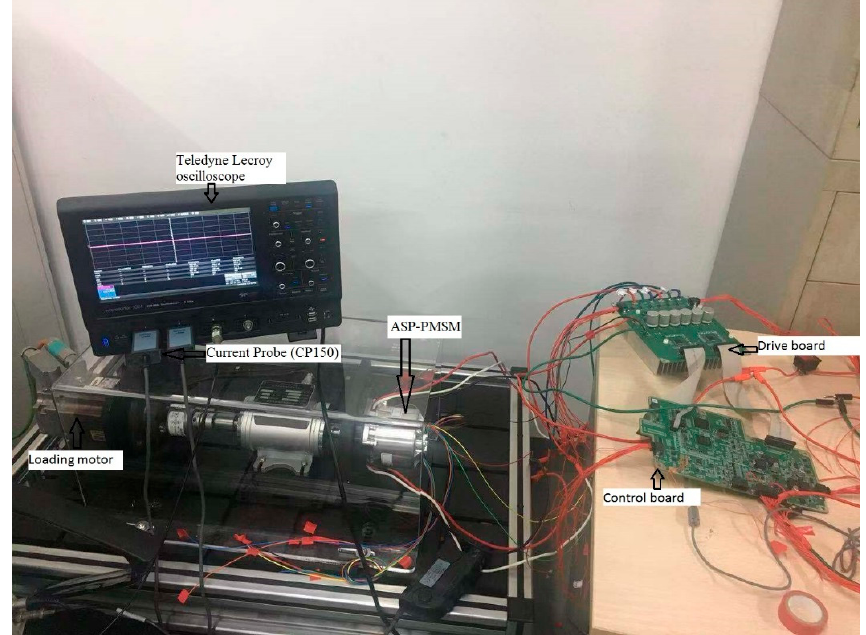
Figure 10. Experimental set-up for ASP-PMSM.